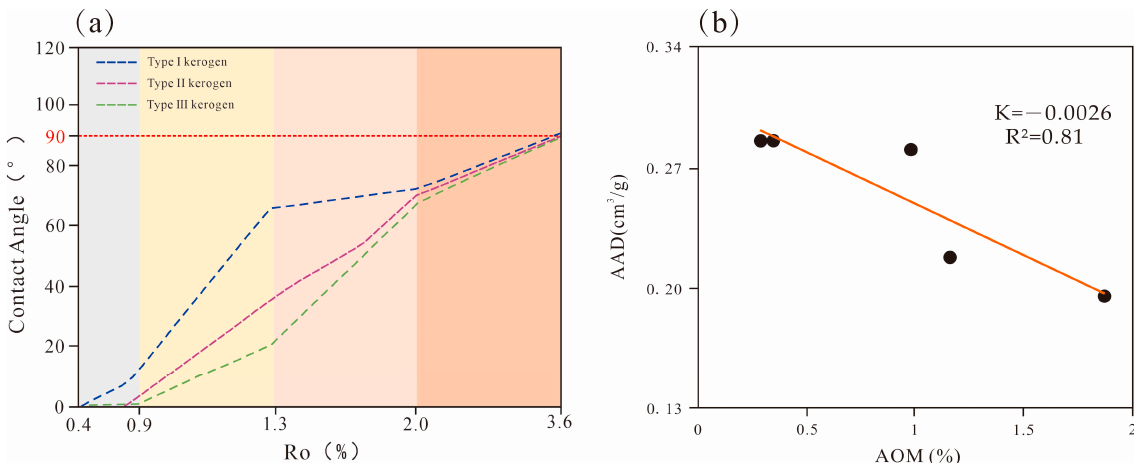
Figure 4. ( a ) Correlation between the water contact angle and maturity of shales with different types of kerogen. A smaller water contact angle indicates a better wettability. The red line is the dividing line between hydrophilic and hydrophobic kerogen. This figure is modified from [141]. ( b ) Correla- tion between the amorphous organic matter content (AOM) and AAD in shales. This figure is de- rived from [88].